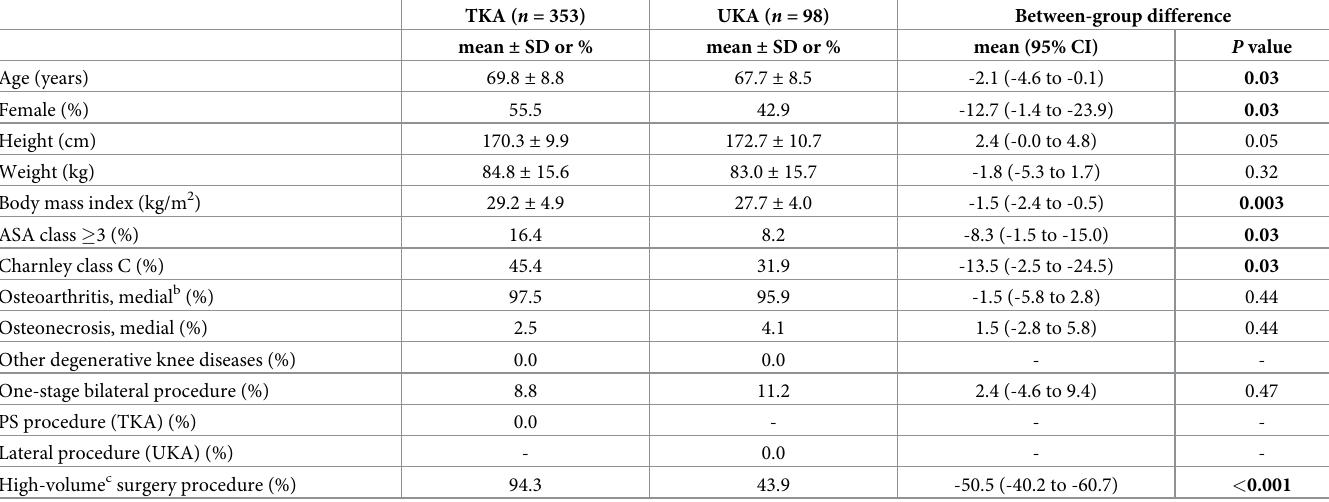
Table 1. Between-group analyses of patient characteristics and perioperative settings in the TKA and UKA subgroups a